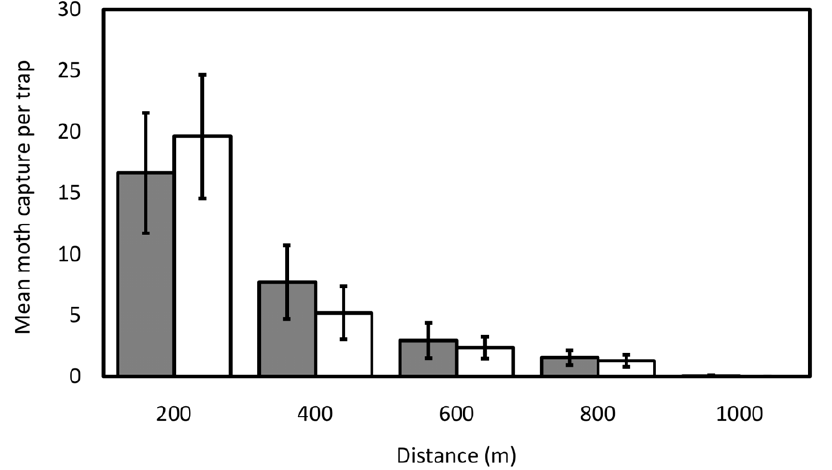
Figure 8. Dispersal of moths beyond release areas. Traps were set at 200 m intervals on cardinal axes outside Field 1. Mean numbers of OX1138B and APHIS moths per trap at each distance from field edge are shown. Filled bars=OX1138B, white bars=APHIS moths; error bars indicate Standard Error of Mean. There was a significant difference in the number of moths caught at different distances between the two strains ( x 2 =29.15, df=4, p , 0.01).